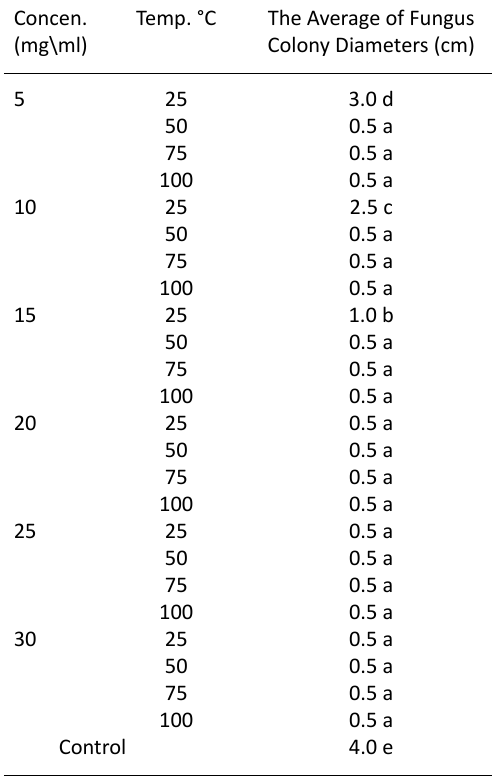
Table 1. The effect of thermal treatments of aqueous chamomile extract on the effectiveness of inhibition growth of Trichophyton rubrum Concen. Temp. °C